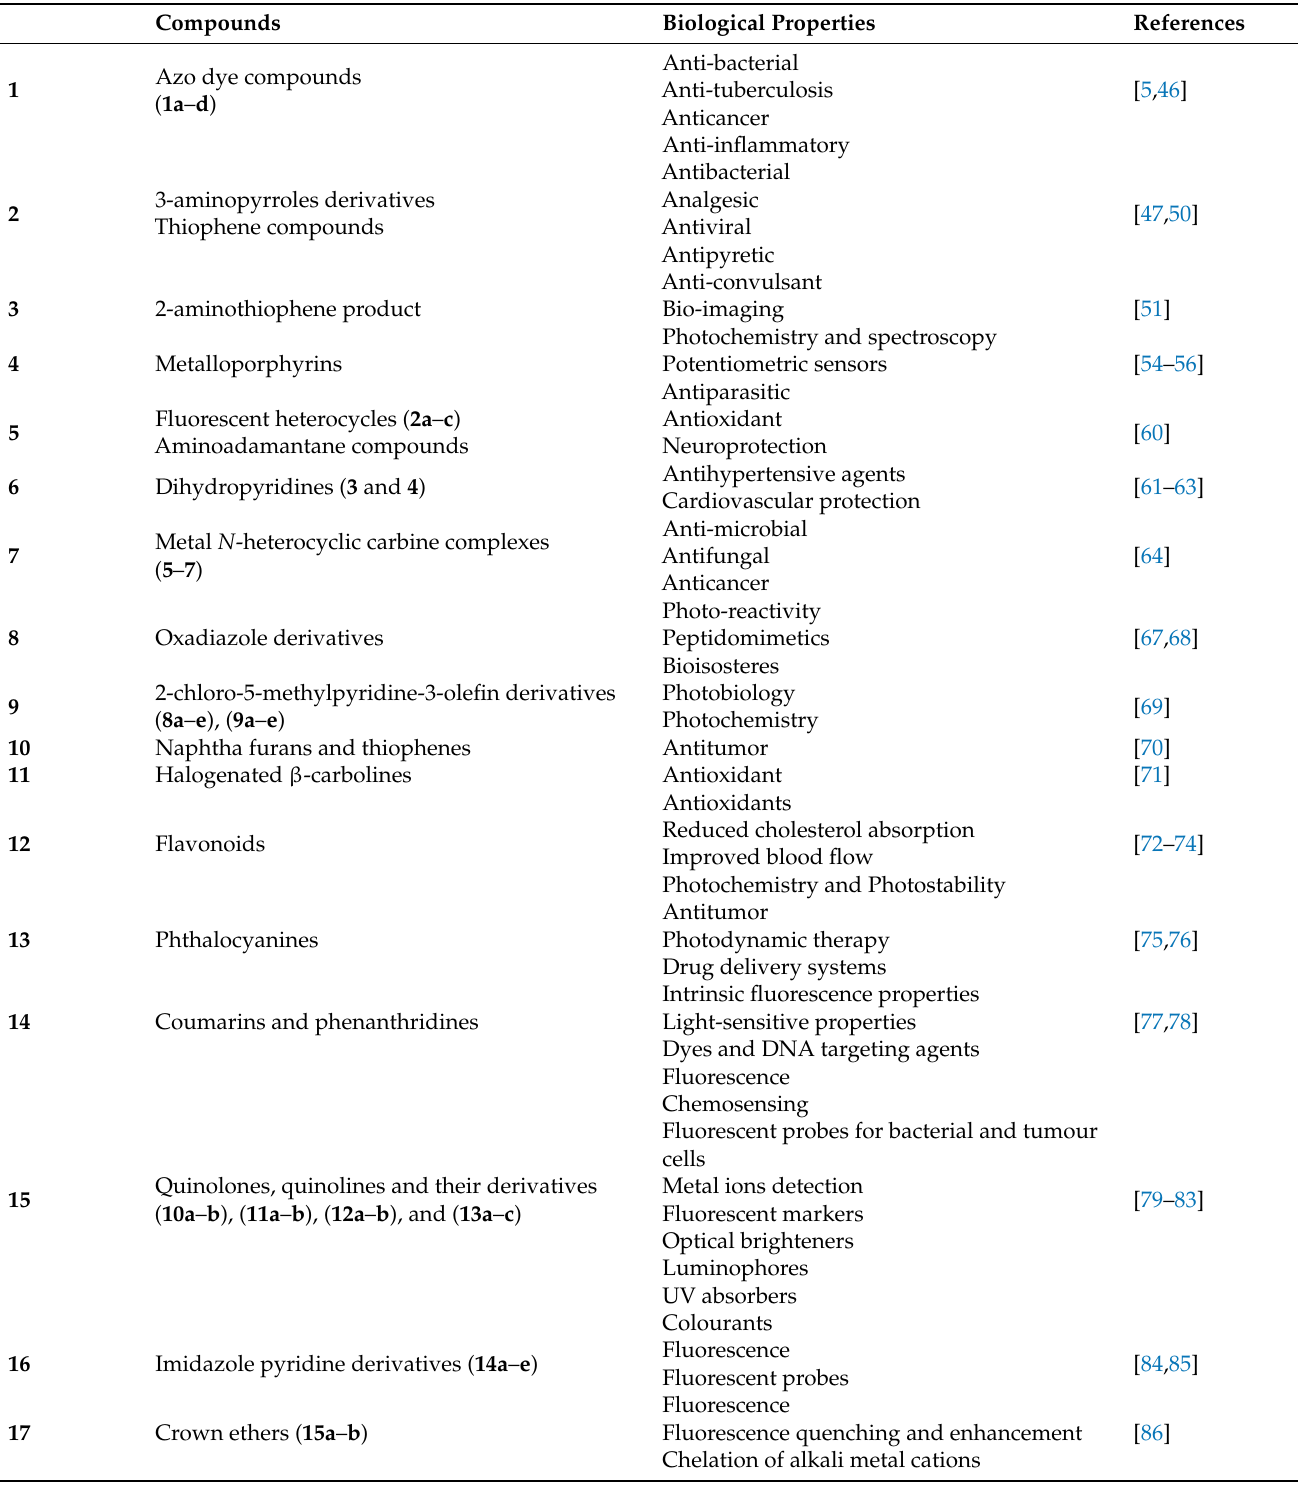
Table 2. Heterocyclic compounds and their